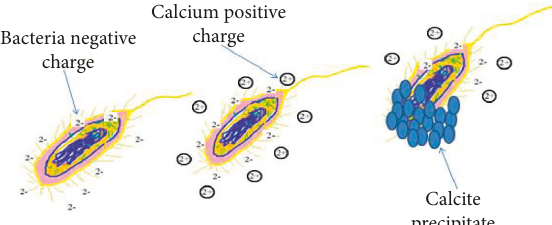
Figure 3: Mechanism of calcite production through cell and calcium ion attraction adopted from [45,